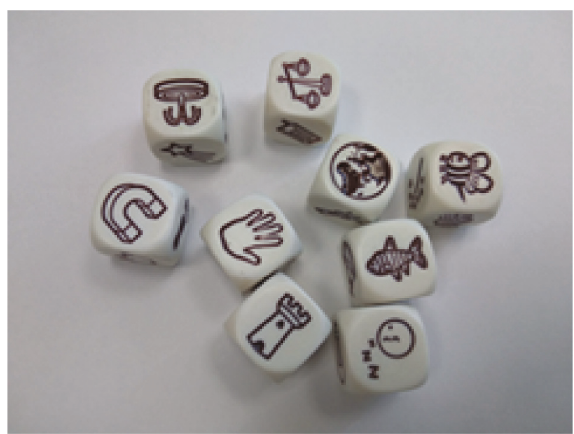
Figure 22: Story cubes used by children to build stories in the second intervention (primary school).